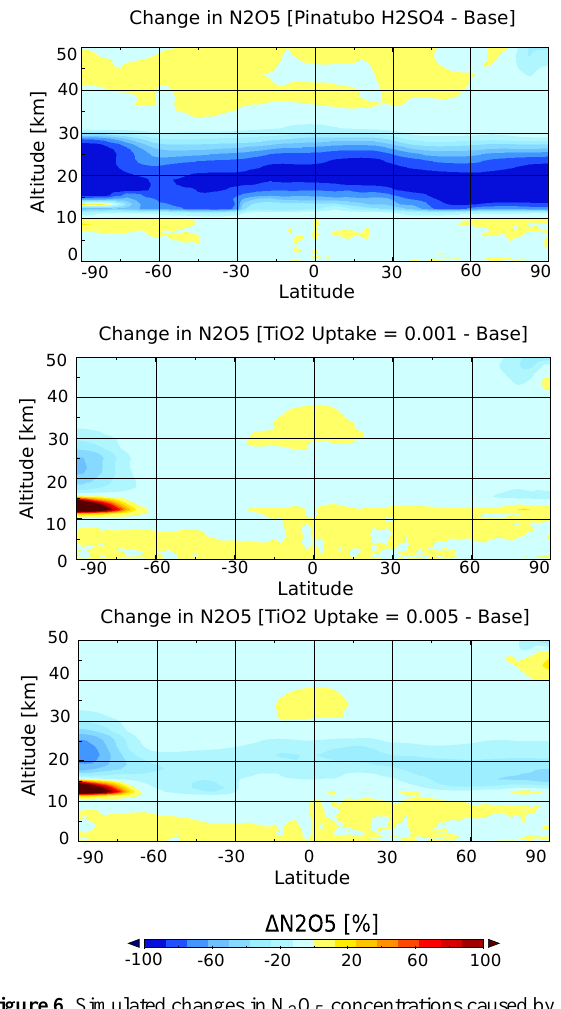
Figure 6. Simulated changes in N 2 O 5 concentrations caused by Mt Pinatubo eruption (Top), and TiO 2 injection with γ (N 2 O 5 ) of 0.001 (middle) and 0.005